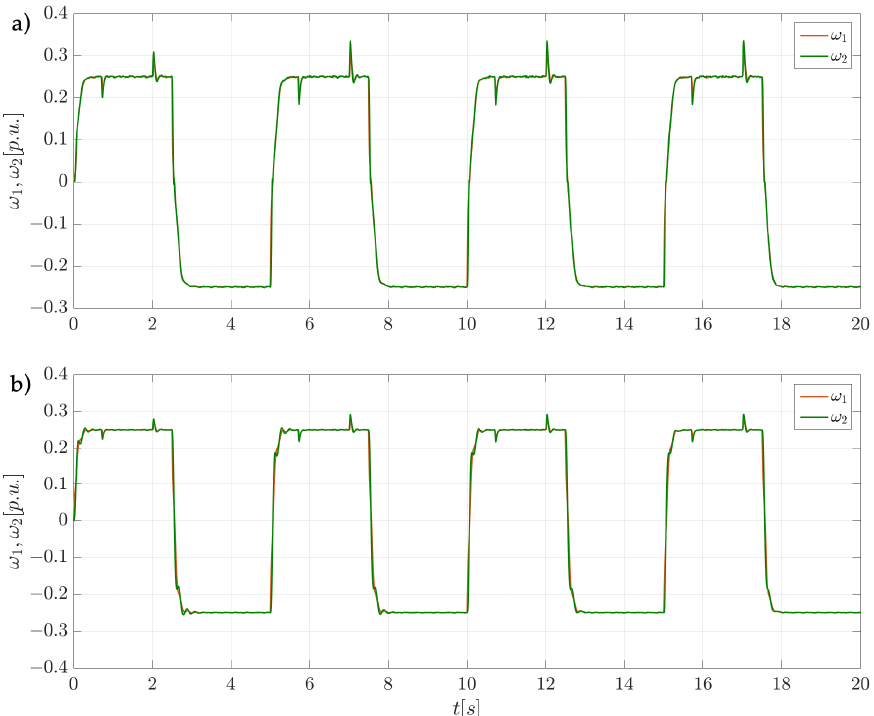
Figure 18. Transients of experimental results for nominal parameters of the drive ( a ) and increased load time constant ( b ).